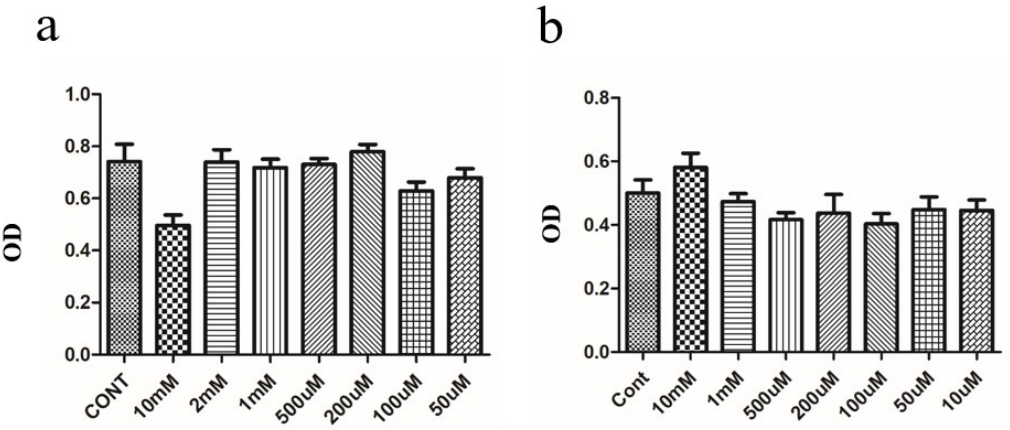
Figure 4. In vitro cell viability of HUVEC cells in the presence of different amounts of AgNCs ( a ) and MOF-AgNCs ( b ).